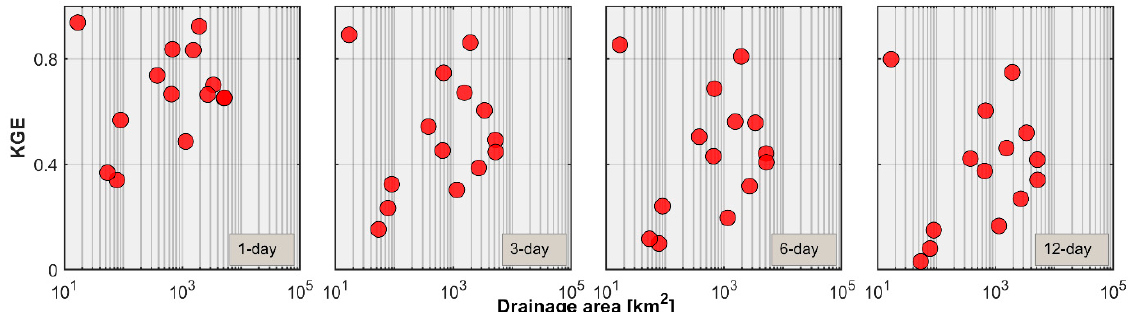
Figure A3. Relationship between KGE and drainage area across lead times for the intermittent flow rivers.